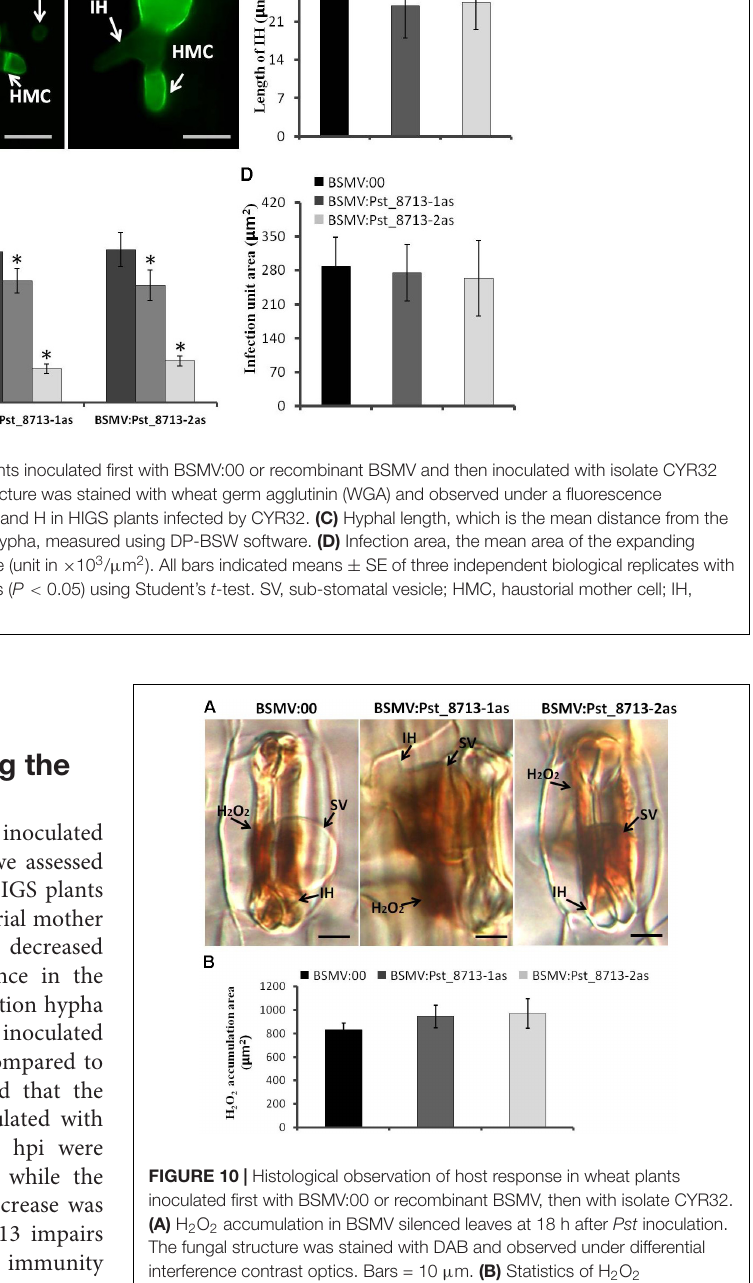
subvert plant defense (Speth et al., 2007). In this study,